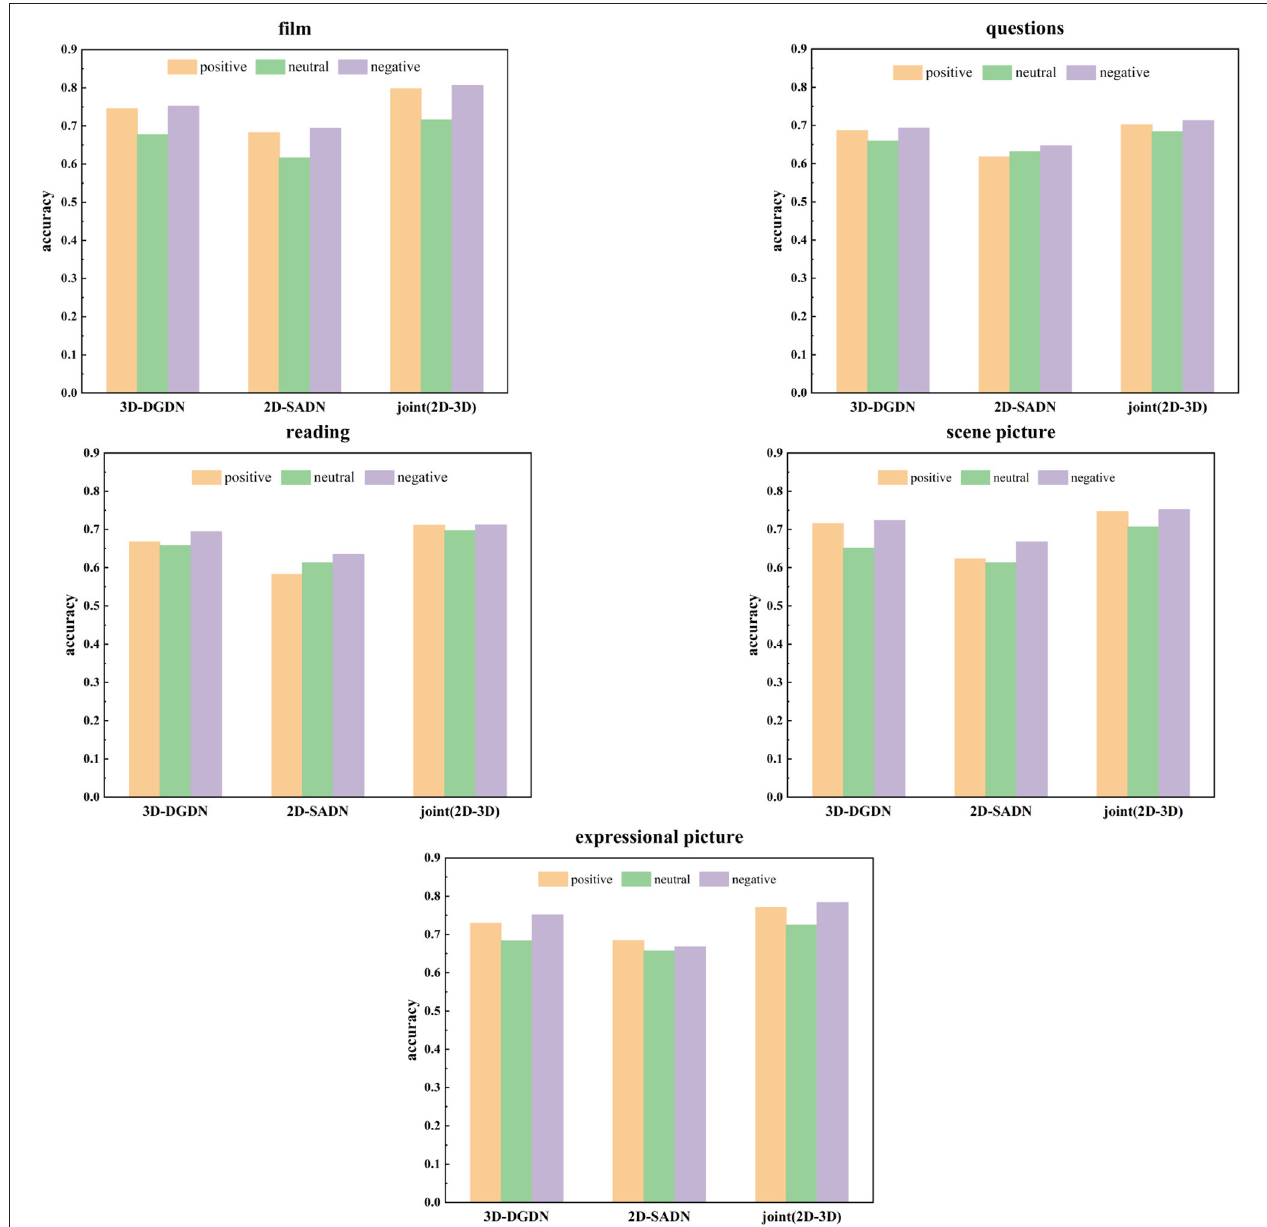
FIGURE 10 | Comparison of accuracy with the five stimuli among three networks.